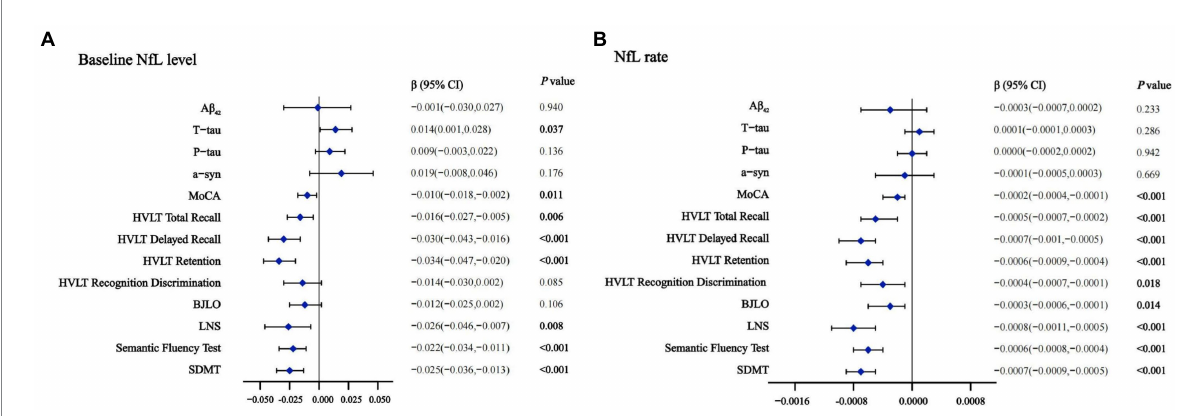
FIGURE 2 Effects of baseline NfL (A) and NfL accumulation rate (B) on CSF biomarkers and cognition measurements in linear mixed-effects analysis among PD participants. Adjusted for age, gender, educated years, APOE ε 4 carrier status and duration. CSF, cerebrospinal fluid; NfL, neurofilament light; PD, Parkinson’s disease; A β 42 , Amyloid- β 42 ; T-tau, Total tau; P-tau, Phosphorylated tau; α -syn, α -synuclein; MoCA, Montreal Cognitive Assessment; HVLT, Hopkins Verbal Learning Test; BJLO, Benton Judgment of Line Orientation Score; LNS, Letter Number Sequencing; SDMT, Symbol Digit Modality